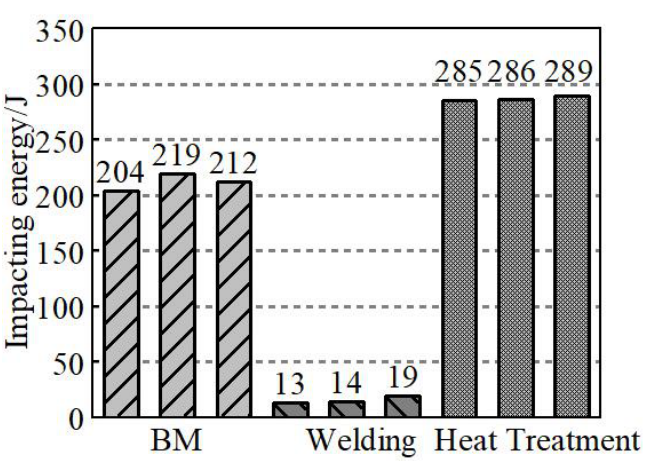
Figure 8. Impact energy of samples.